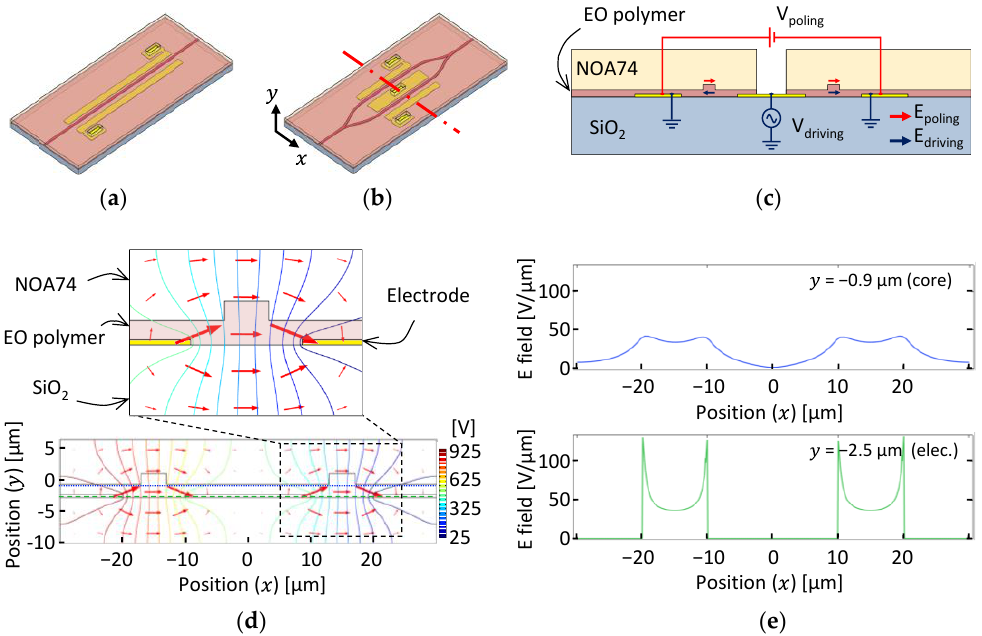
Figure 3. Overview of a ( a ) straight waveguide polarization modulator device and ( b ) Mach–Zehnder intensity modulator device. ( c ) Device cross-section showing the directions of the poling field and driving field for push–pull operation. ( d ) Electric potential and field distributions produced by the coplanar electrodes. ( e ) Electric field plot along the horizontal direction at the vertical positions of the waveguide center (along the dotted line in ( d )) and the electrode (along the dashed line in ( d )).